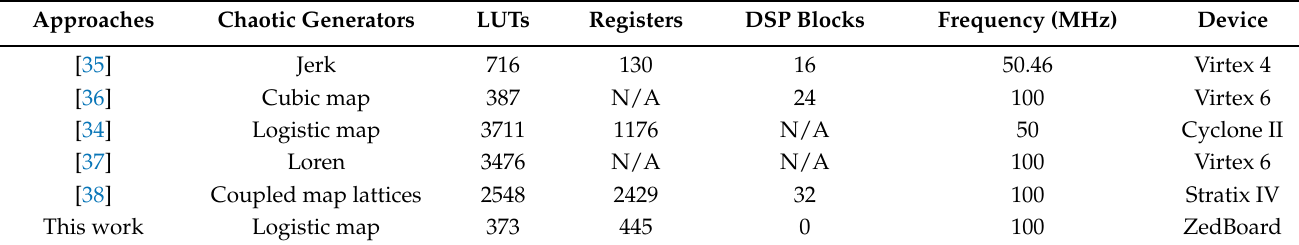
Table 4. Comparison of resource consumption based on different